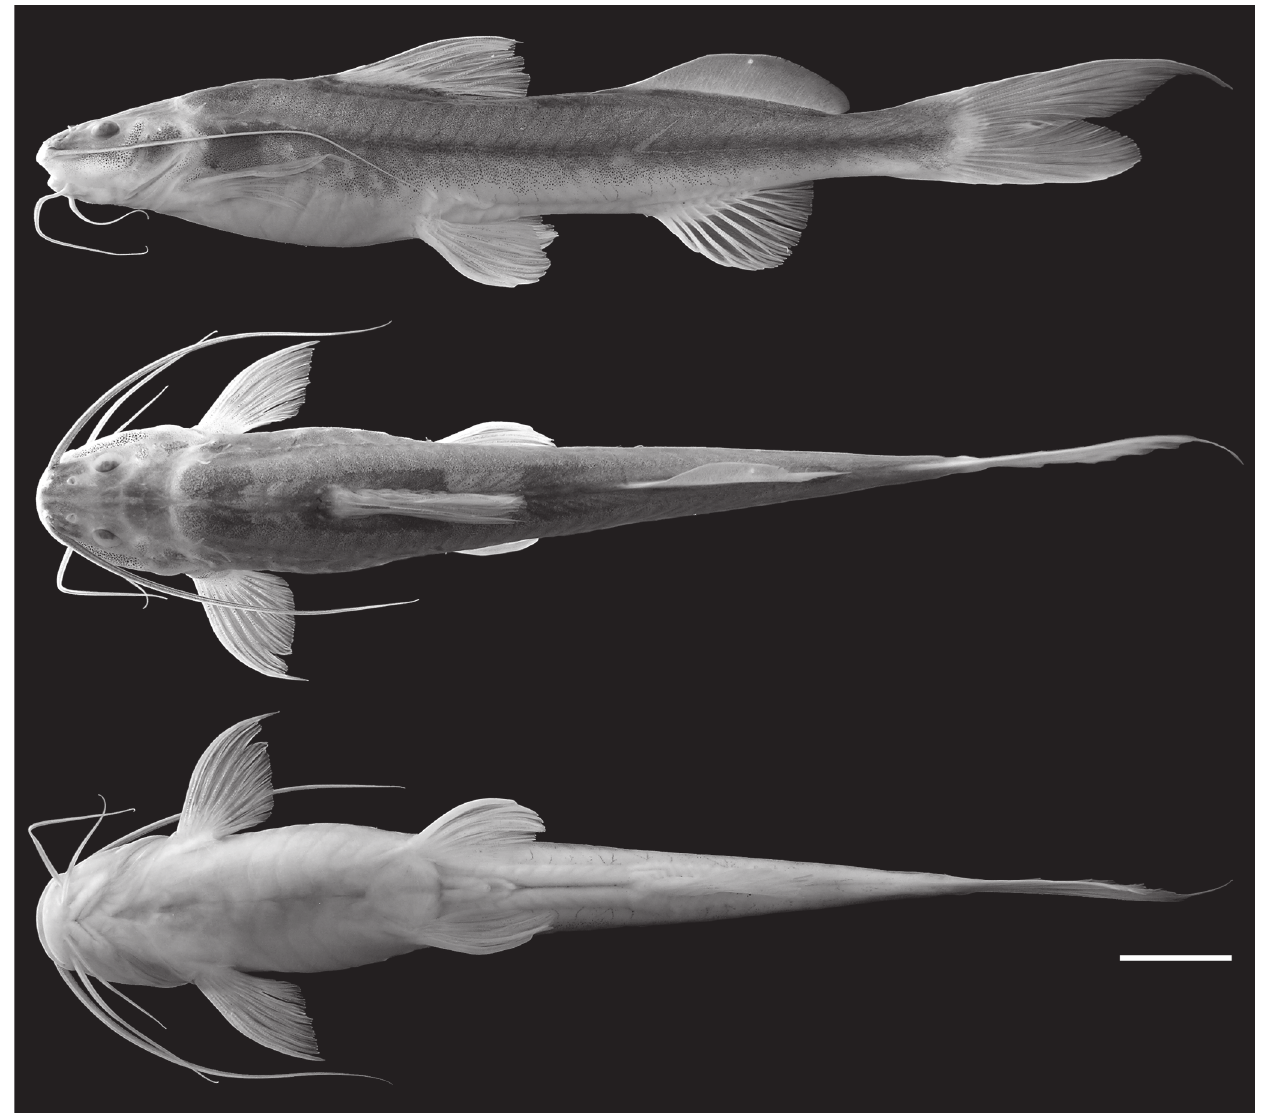
Fig. 3. Imparfinis usmai , holotype, IMCN 4812, 83.4 mm SL, Colombia, Departamento del Tolima , Municipio Coello, vereda Potrerillo, quebrada Potrerilla, tributary of río Coello, río Magdalena basin, 04°16’57.9”N 75°01’53.8”W. Scale bar = 1 cm.